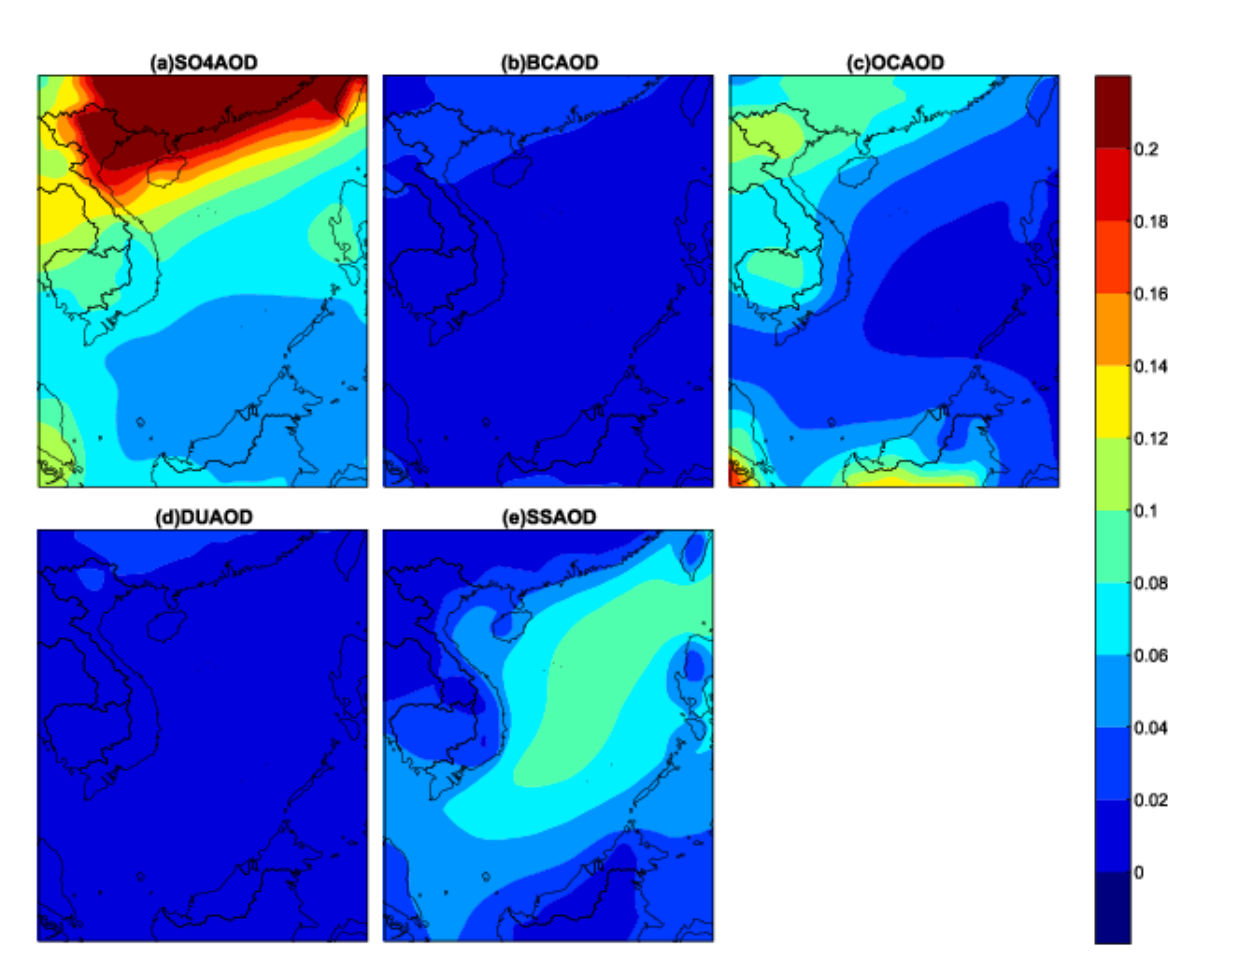
Figure 6. Spatial distribution of mean MERRA-2 values of ( a ) SO 4 AOD, ( b ) BCAOD, ( c ) OCAOD, ( d ) DUAOD, and ( e ) SSAOD over the SCS during the period of 1980–2020.